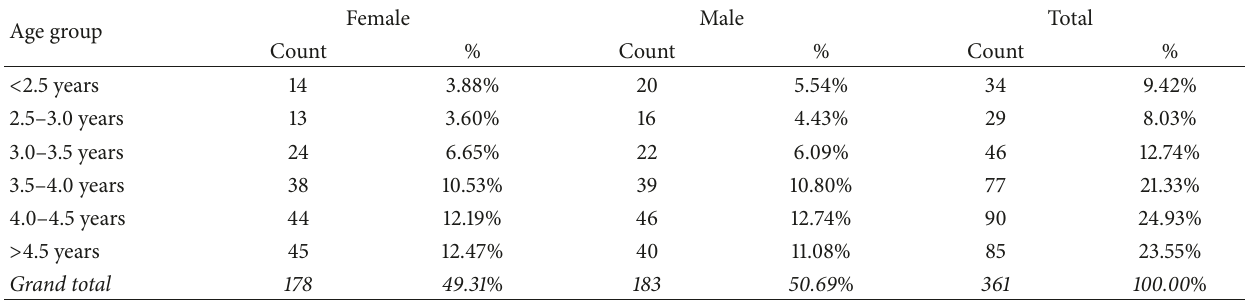
Table 2: Age/sex distribution of the sampled study population ( 𝑛 =